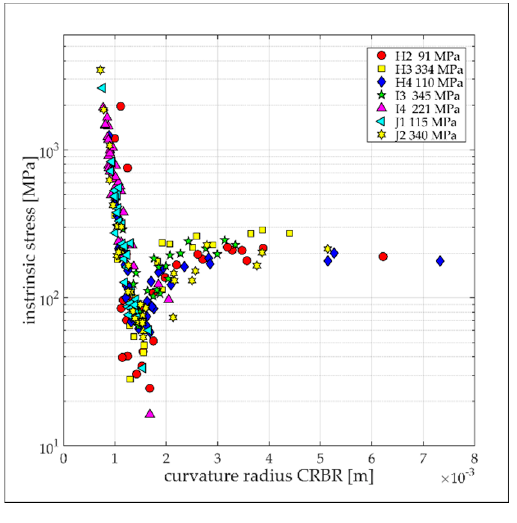
Figure 12. Intrinsic stress as a function of the CRBR for different mono- and multi-layer coatings. The stress values are only valid for diaphragms with a flat surface geometry (group 2, CRBR > 1.3 mm). The stress levels of the coatings deposited on SCS beams are indicated in the legend.